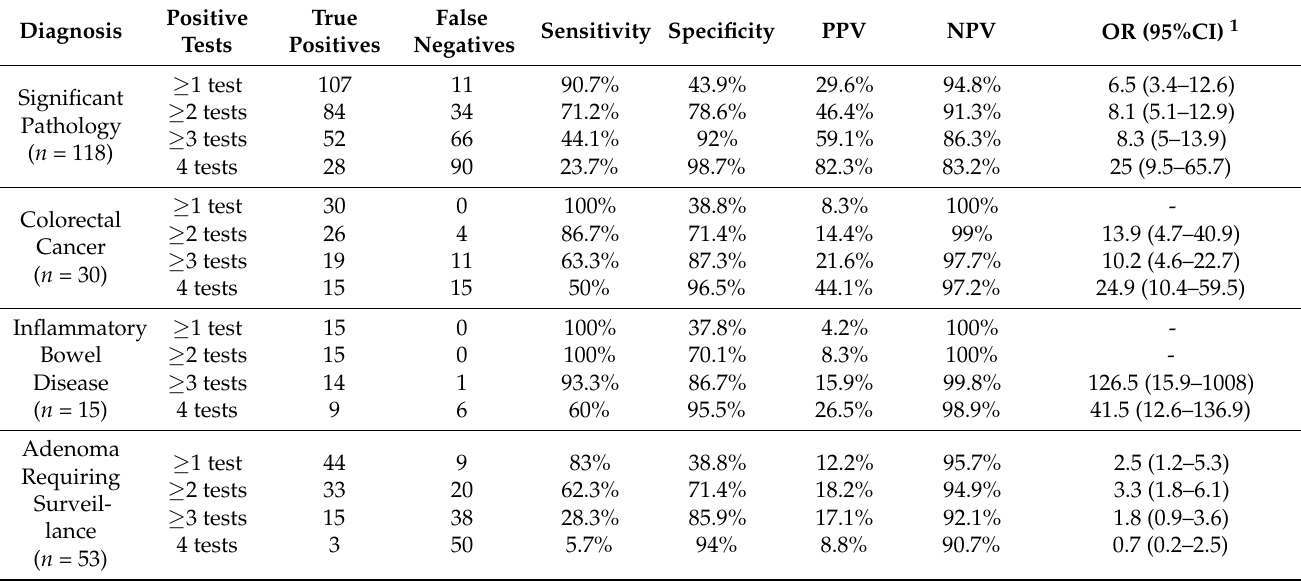
Table 4. Diagnostic accuracy of the combined POC faecal test, considering the four possible cut-offs according to the number of positive